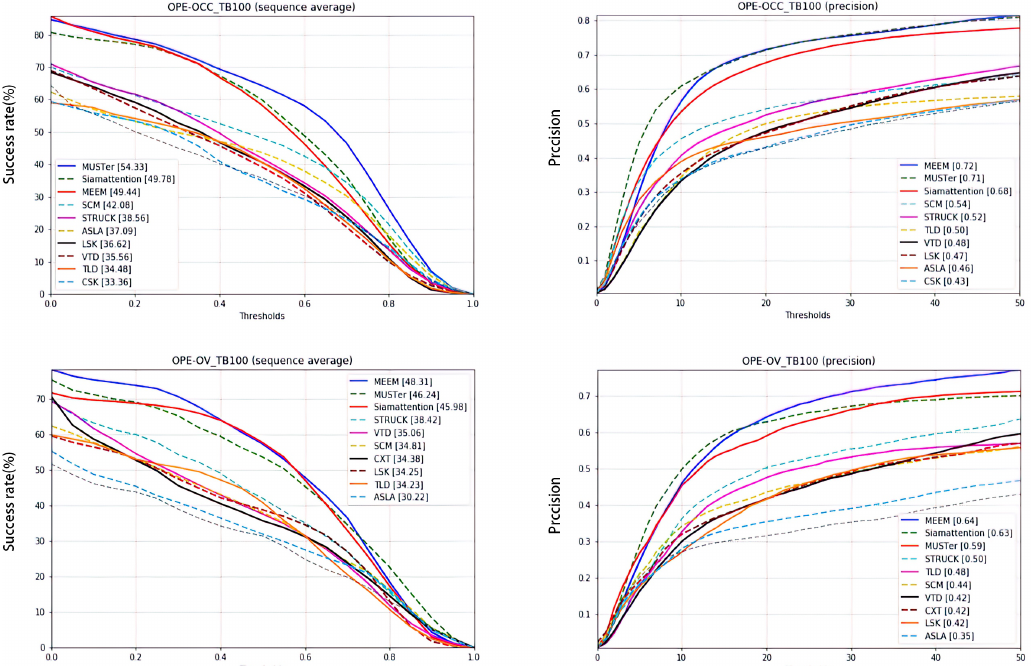
Figure 10. Success plot and precision plot of OCC and OV. Under OCC conditions, the proposed tracker is shown as the green dotted line in the success plot, ranking second, and as the red solid line in the precision plot, ranking third. Under OV conditions, it is shown as the red real line in the success plot, ranking third, and the green virtual line in the precision plot, ranking